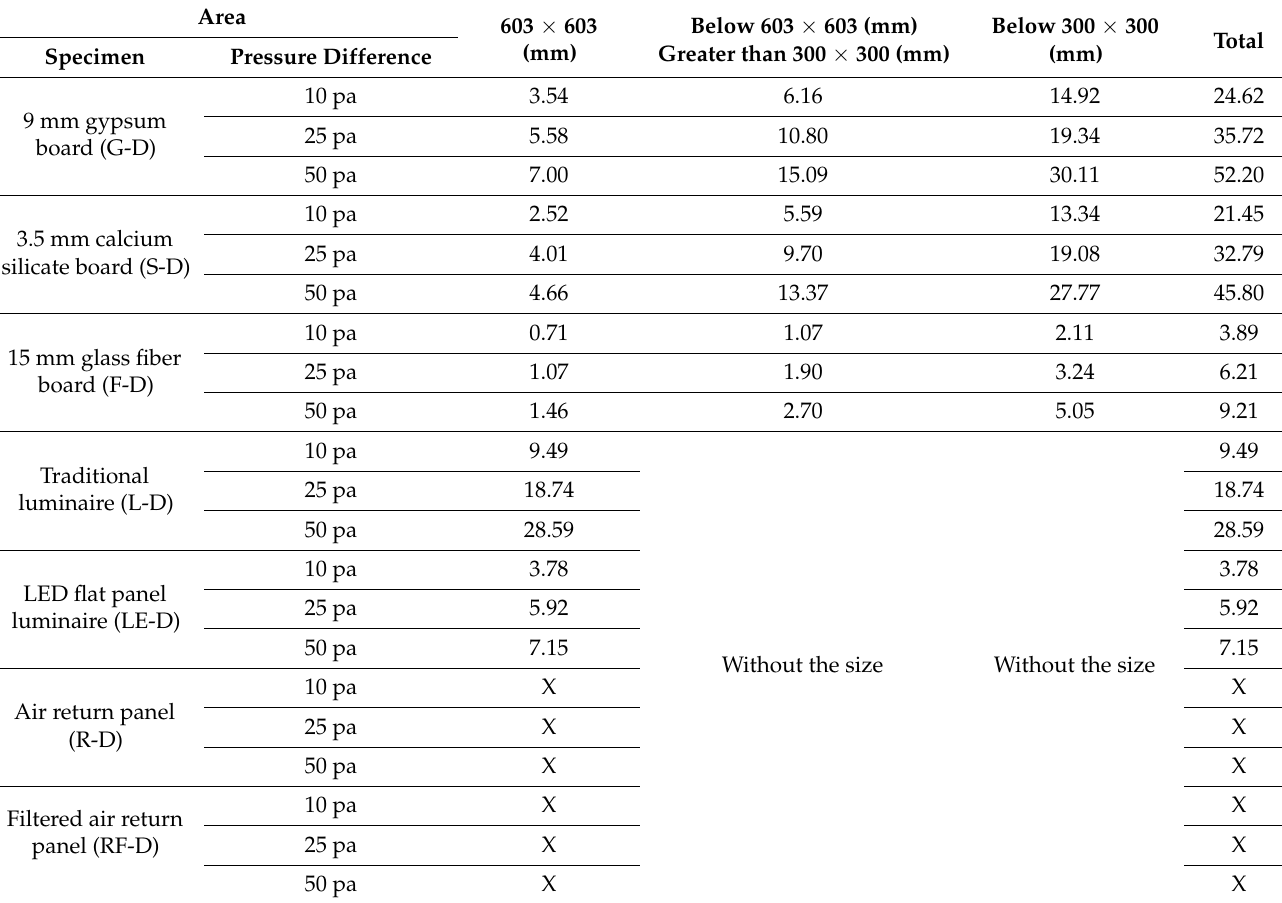
Below 603 × 603 (mm) Below 300 × 300 Total (mm) Greater than 300 × 300 (mm) (mm)